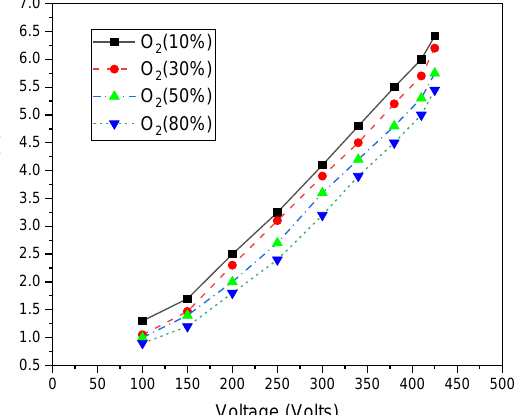
Figure 8. The current–voltage curve at various O 2 gas rates, f = 13.56 MHz, and working pressure 0.3 Torr.